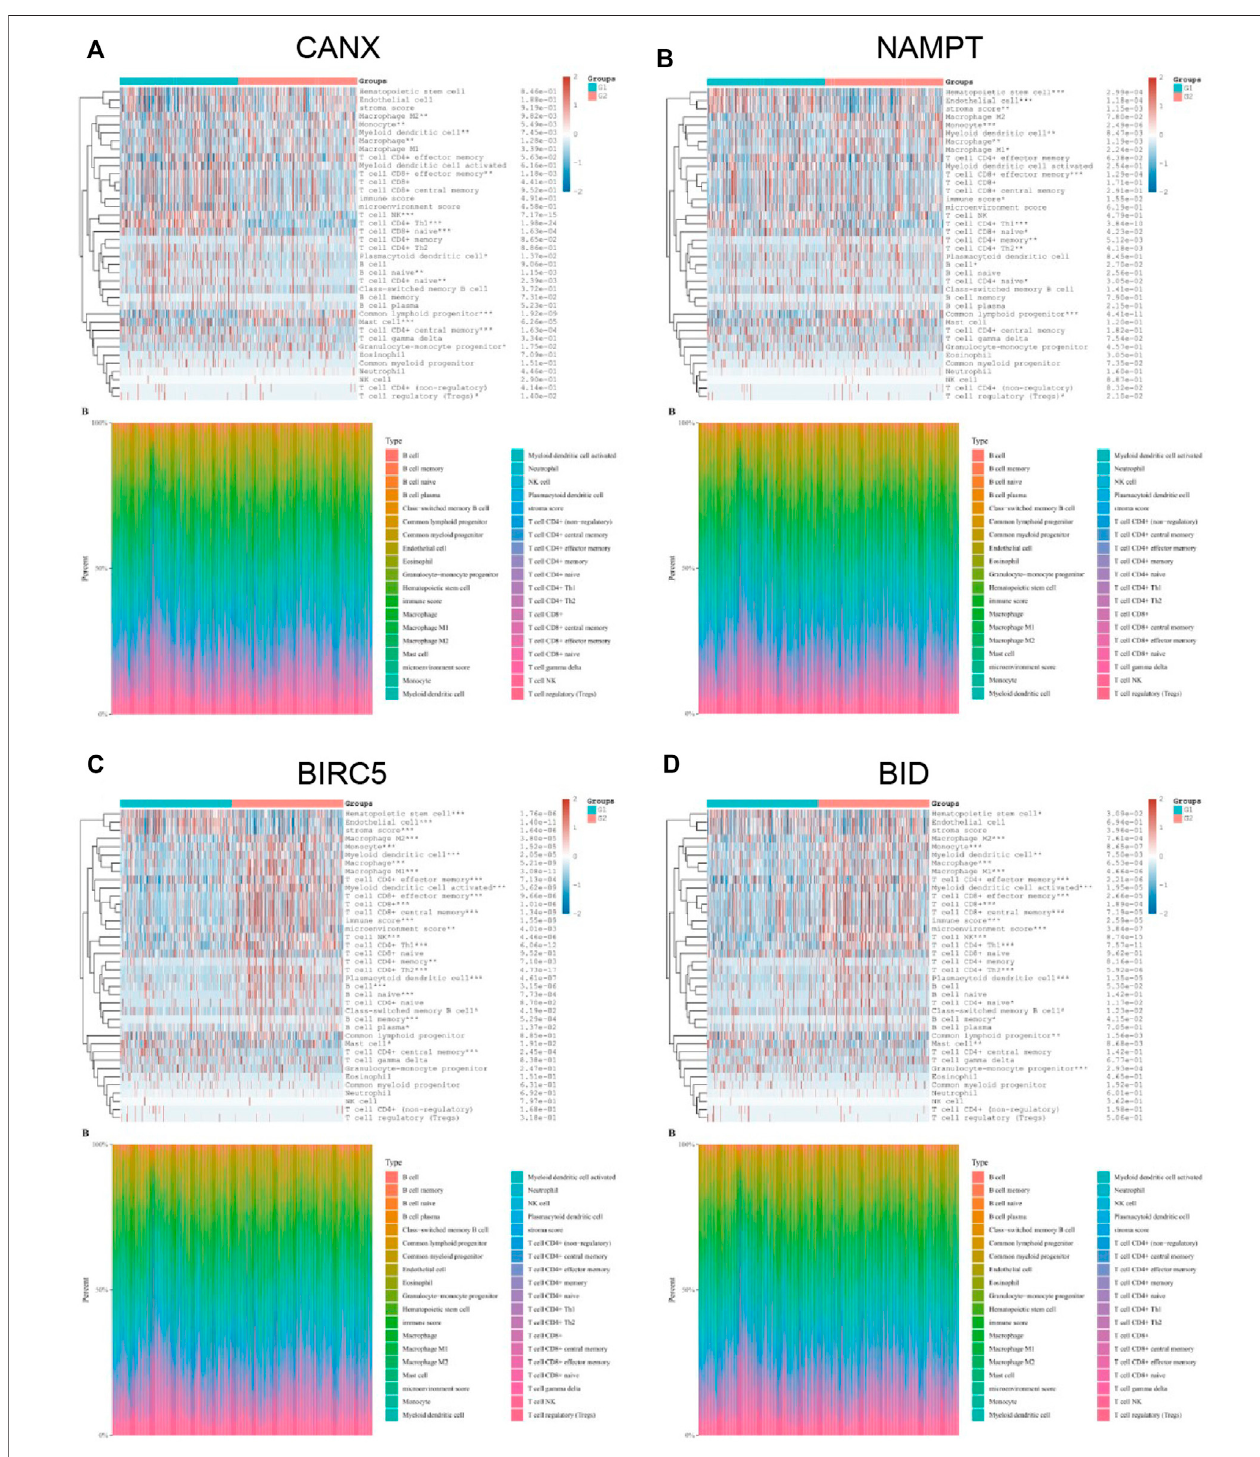
FIGURE 7 | Correlation between the expression of immune in fi ltrating cells in kidney renal clear cell carcinoma (KIRC) tissues and immune-autophagy-related differentially expressed genes (DEGs). The difference of expression of immune in fi ltration cells in KIRC tissues with high and low CANX (A) , NAMPT (B) , BIRC5 (C) , and BID (D) gene expression. G1 is a low-expression group, and G2 is a high-expression group.